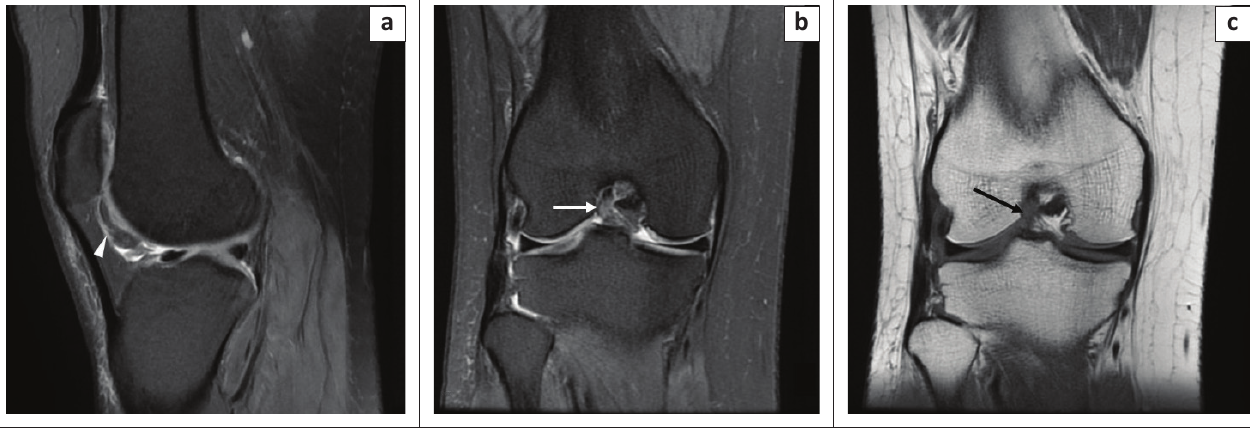
FIG URE 9: Magnetic resonance imaging of an infrapatellar plica tear in a 33-year-old patient with a twisting injury to the knee and clinically-suspected anterior cruciate ligament (ACL) injury: oblique sagittal PDFS image (a) revealed a hyperintense fluid collection along the entire course of the infrapatellar plica (arrow head), with irregular margins. Coronal PDFS image shows hyperintense signal along the ACL with intact fibres suggestive of mild sprain in the postero-lateral bundle of the ACL (arrow). Corresponding signal alteration on T1WI is shown in